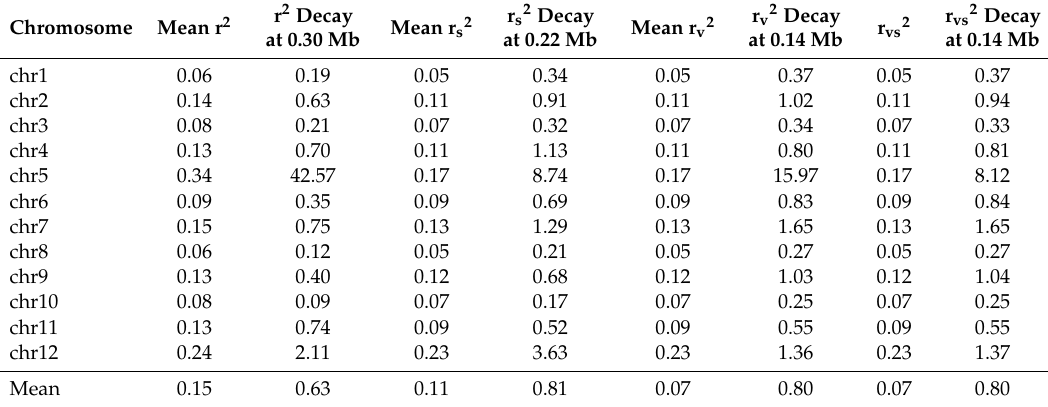
Table 4. Linkage disequilibrium levels overall and within chromosomes, as calculated using standard r 2 and (r 2 ) corrected for population structure (r s2 ), kinship (r v2 ) and both population structure and kinship (r vs2 ).